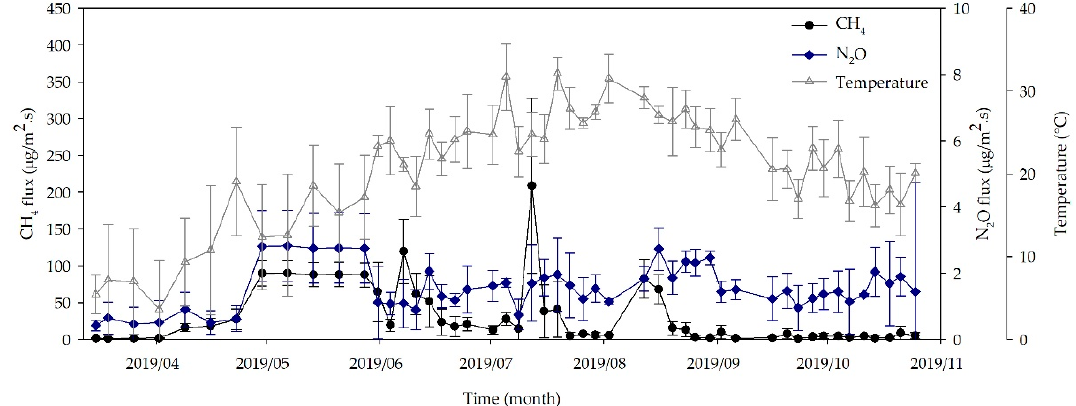
Figure 8. Variation in average CH 4 and N 2 O fluxes from manure composting lot on the day of sampling during the study (error bars represent the standard deviation of the average).